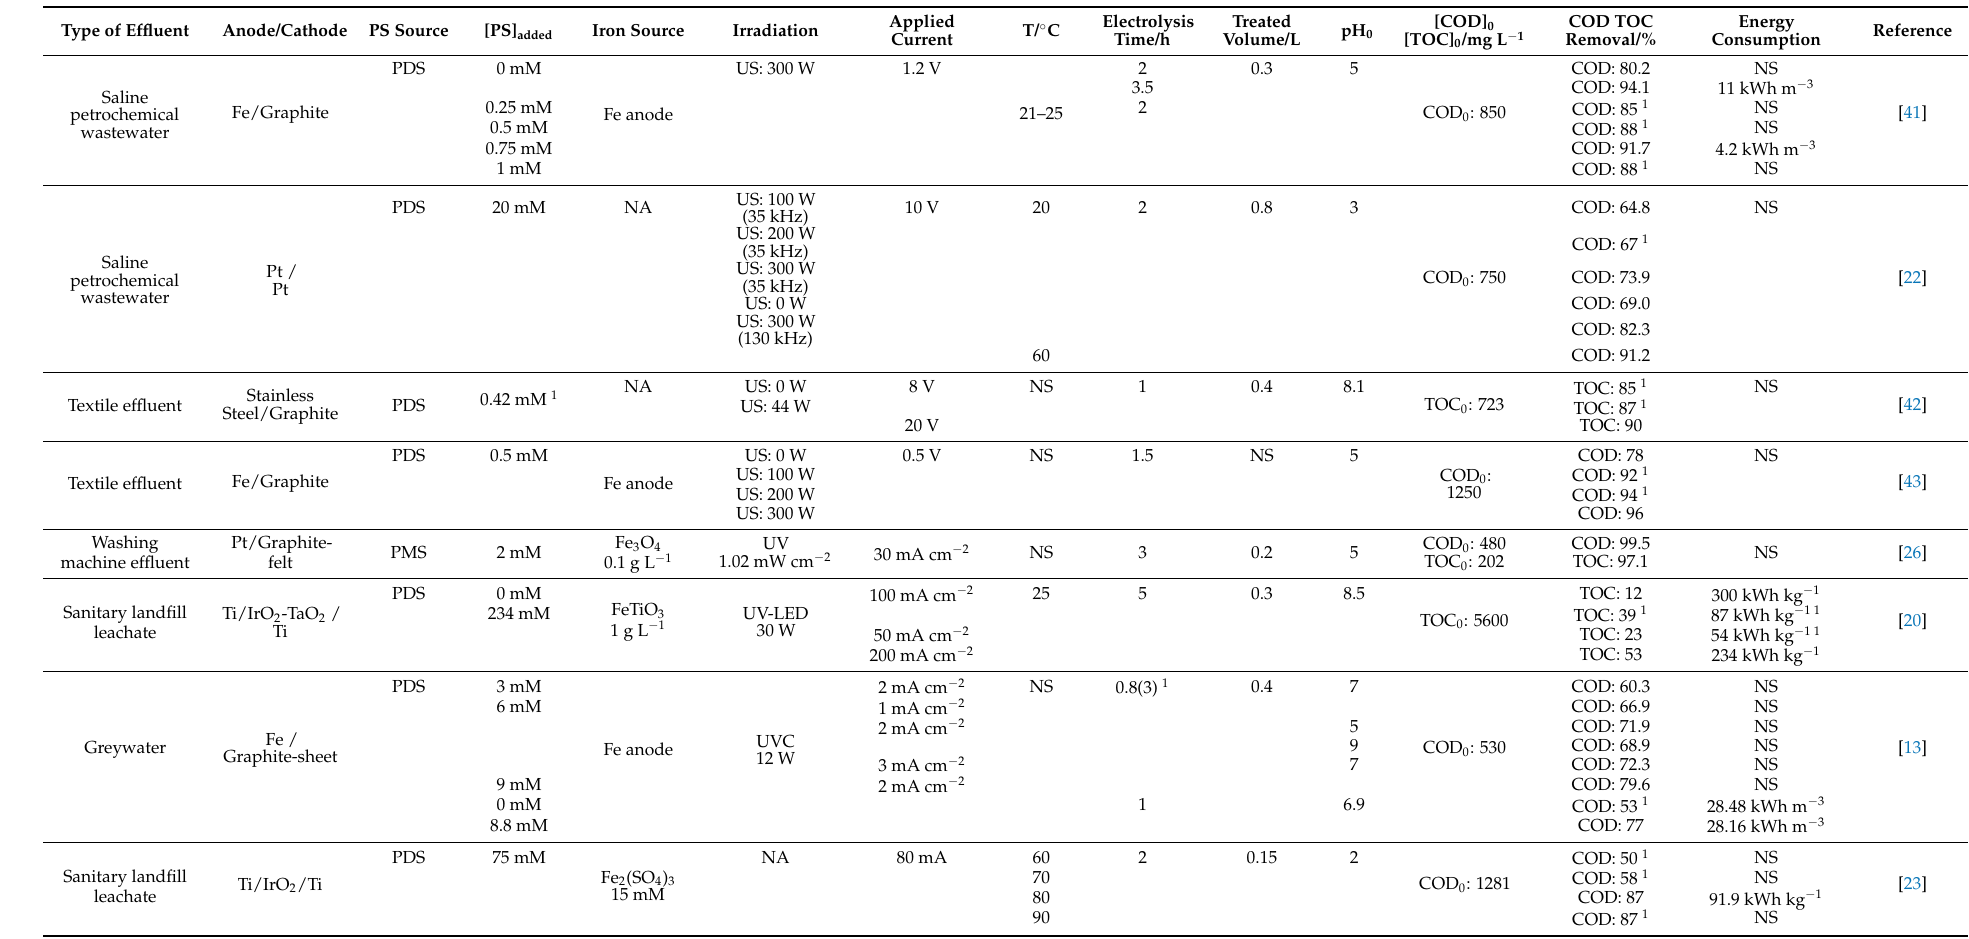
Table 5. Summary of research results previously reported for electro-persulfate processes involving co-activation by irradiation or heat in the treatment of complex